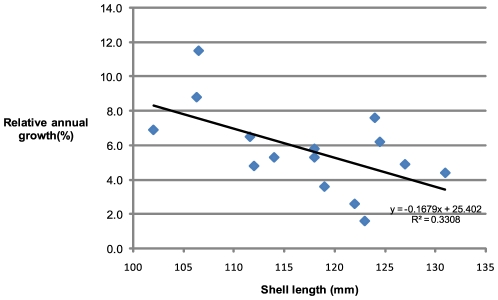
Relative annual growth rates compared to shell length at first capture.The relative annual growth rate of each individual immature Nautilus when compared with shell length at time of first capture is indicative (R2 = 0.3308) of growth rates decreasing as maturity is approached.